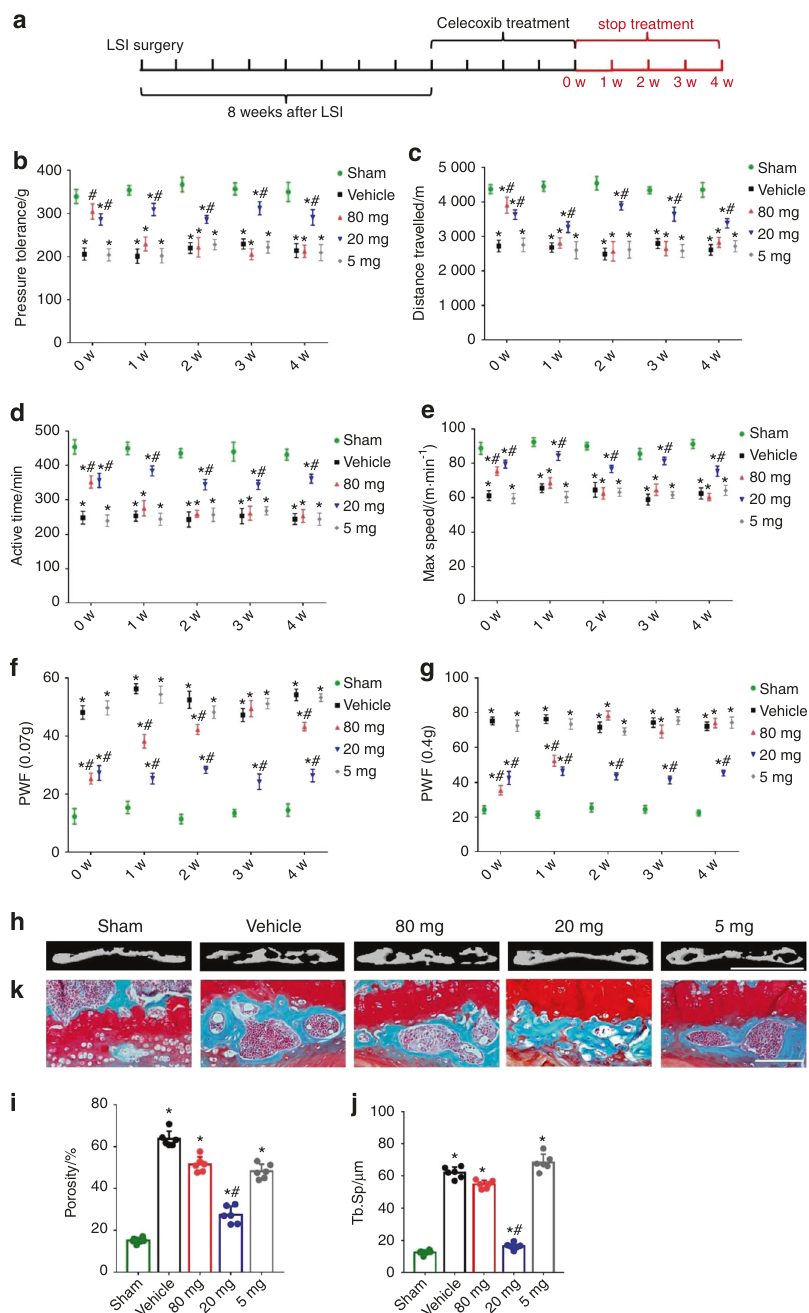
Fig. 7 Spinal pain hypersensitivity remained relieved after discontinuation of low-dose celecoxib treatment. a Spinal pain and endplate porosity were measured at 4 weeks after discontinuation of celecoxib or vehicle treatment. b Vocalization thresholds of the mice with LSI surgery at 4 weeks after the discontinuation of celecoxib or vehicle treatment. Spontaneous activity results, including distance traveled ( c ), active time per 24 h ( d ), and maximum speed ( e ). f , g The PWF in the von Frey test (0.07 g and 0.4 g). h Representative μ CT images of the L4-L5 caudal endplates at 4 weeks after the discontinuation of celecoxib or vehicle treatment. Scale bars, 1 mm. Quantitative analysis of the total porosity ( i ) and trabecular separation ( j ) of the L4-L5 caudal endplates based on the μ CT images. * P < 0.05 compared with the sham group and # P < 0.05 com p ared with the vehicle group at the corresponding time points. n = 6 per group. k Representative safranin O and fast green staining images of the L4-L5 caudal endplate sections at 4 weeks after the discontinuation of celecoxib or vehicle treatment. Scale bars, 50 μ provides potential diagnostic and treatment for LBP related to the including IVD, endplate and facet joints, that are involved in LBP. porosity of endplates. 10,50,51 Elevated PGE2 concentrations and Endplates undergo ossi fi cation and become highly porous during IVD degeneration 16,17 with more nerve innervation in degenera- increased sensory nerve innervation exist in porous and sclerotic vertebral endplates, and PGE2 activates EP4 receptors in the tive endplates than in healthy endplates. 19 Recent clinical studies sprouting nerves to cause spinal pain. 20 In this study, celecoxib at have revealed that Modic changes in endplates and vertebral bone marrow lesions on MRI or CT are associated with LBP, which a low dose (20 mg·kg − 1 per day), which is equivalent to one-